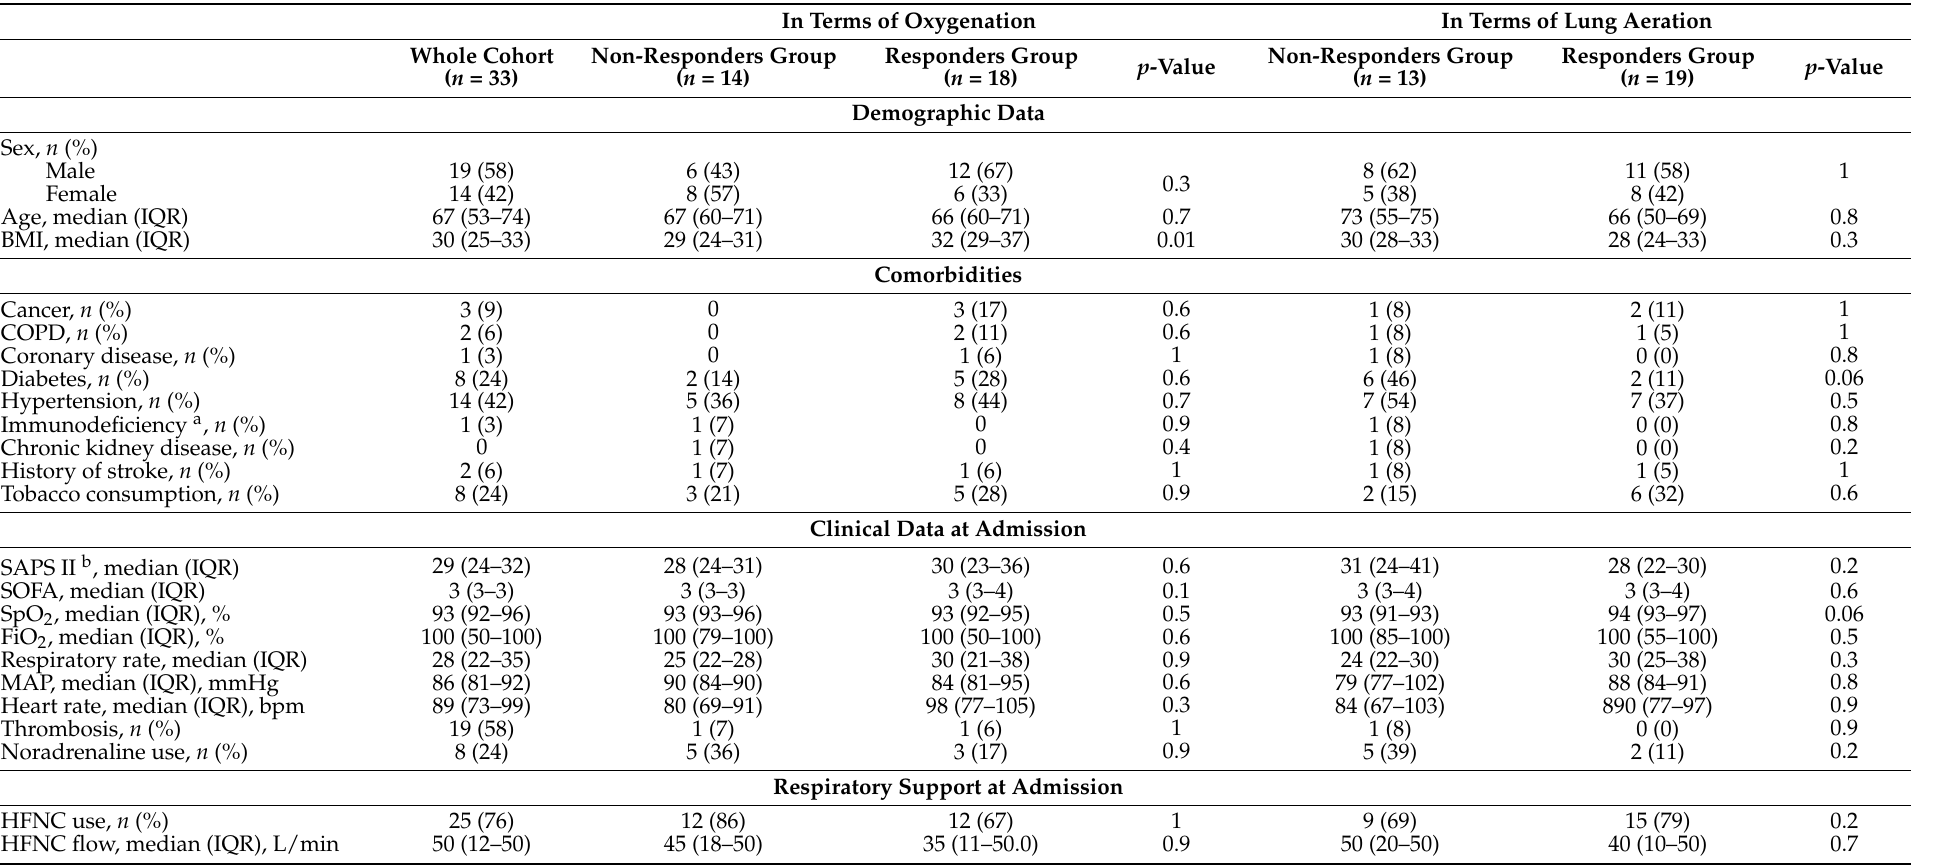
Table 1. Baseline clinical data of patients in the whole cohort and according to their response to chair positioning in terms of oxygenation and lung